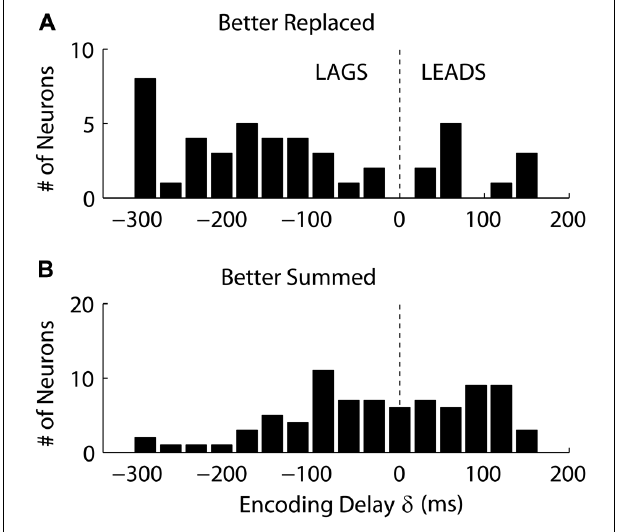
FIGURE 9 |The distribution of the encoding time delay δ is compared between neurons which were better fit with the “Replaced” hypothesis (A), versus neurons better fit with the “Summed” hypothesis (B). Only neurons which showed a significant difference in single-trial root-mean-square error between the two hypotheses are shown (see Results for